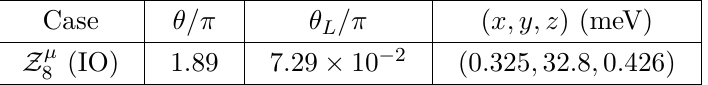
Table 4 . Values of the θ , θ L , x , y and z input parameters in eq. (4.9) which lead to the best-fit case shown in table